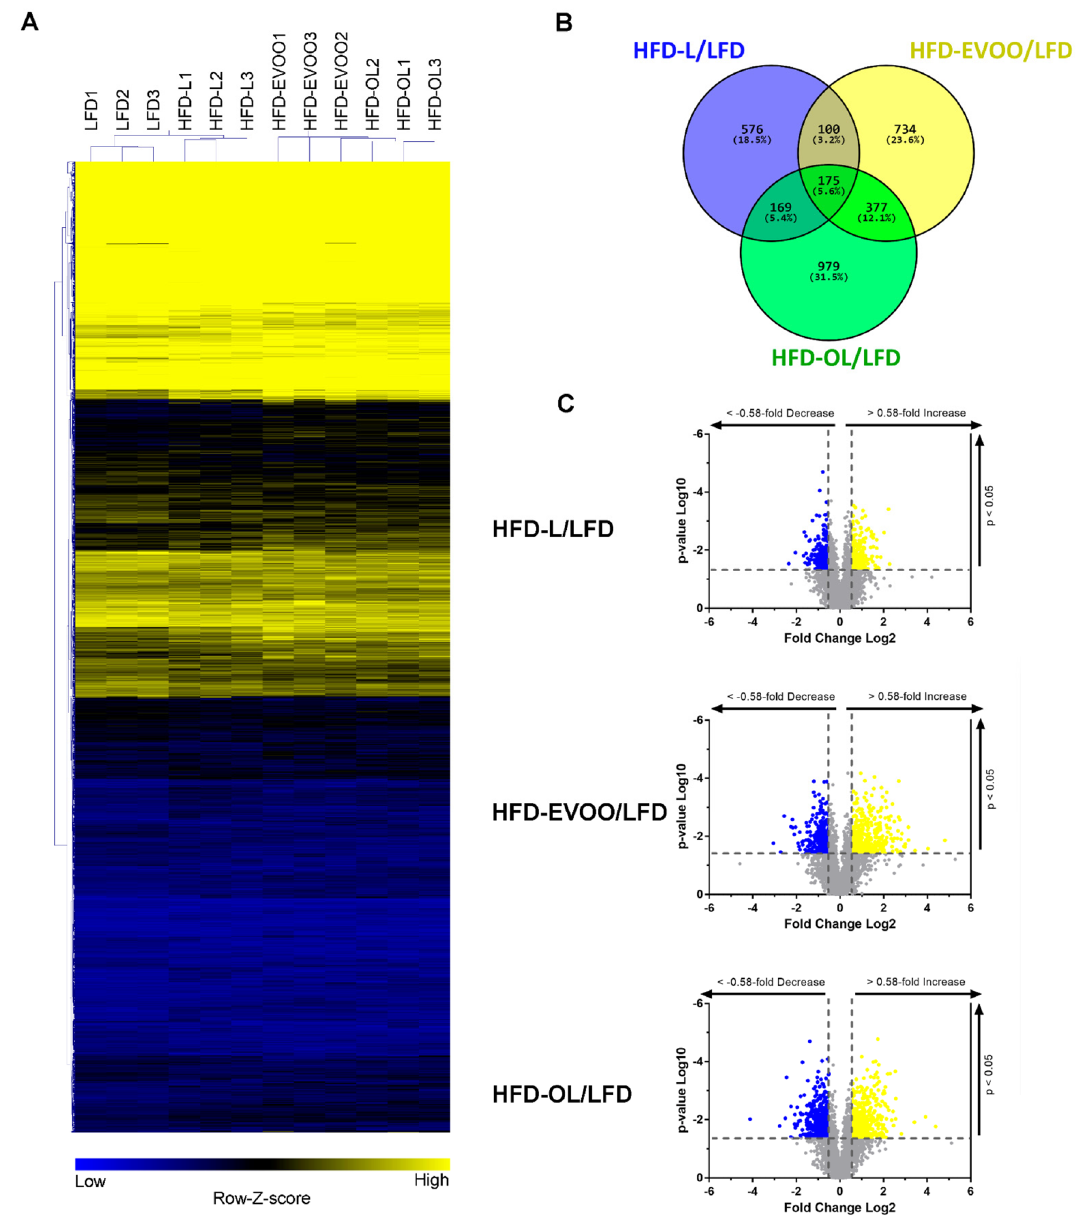
Figure 6. Hierarchical clustering, Venn diagram and scatter plots of differential expression profiles of LFD, HFD-L, HFD-EVOO and HFD-OL liver genes. ( A ) Hierarchical clustering of differential expression profiles of LFD, HFD-L, HFD-EVOO and HFD-OL genes, performed using Euclidean distance according to expression pattern with the MeV software. Scaled expression value, expressed as the row Z-score, is plotted in yellow- blue color scale, with yellow indicating high expression and blue indicating low expression. ( B ) Venn diagram showing the number and percentage of DEGs (up-regulated and down-regulated) shared by HFD-L, HFD- EVOO and/or HFD-OL relative to LFD. ( C ) Scatter plot showing the fold change and statistical significance of genes when comparing HFD-L, HFD-EVOO or HFD-OL relative to LFD. The yellow and blue dots represent up- and down-regulated genes, respectively, with statistical significance. The grey dots represent the genes without significant differential